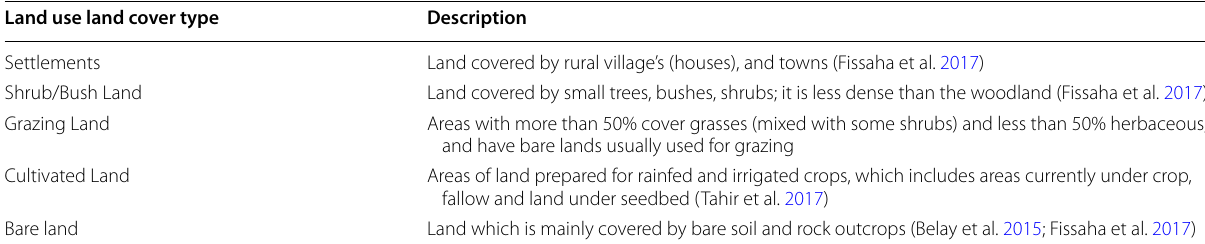
Table 2 Description of land cover types Land use land cover type